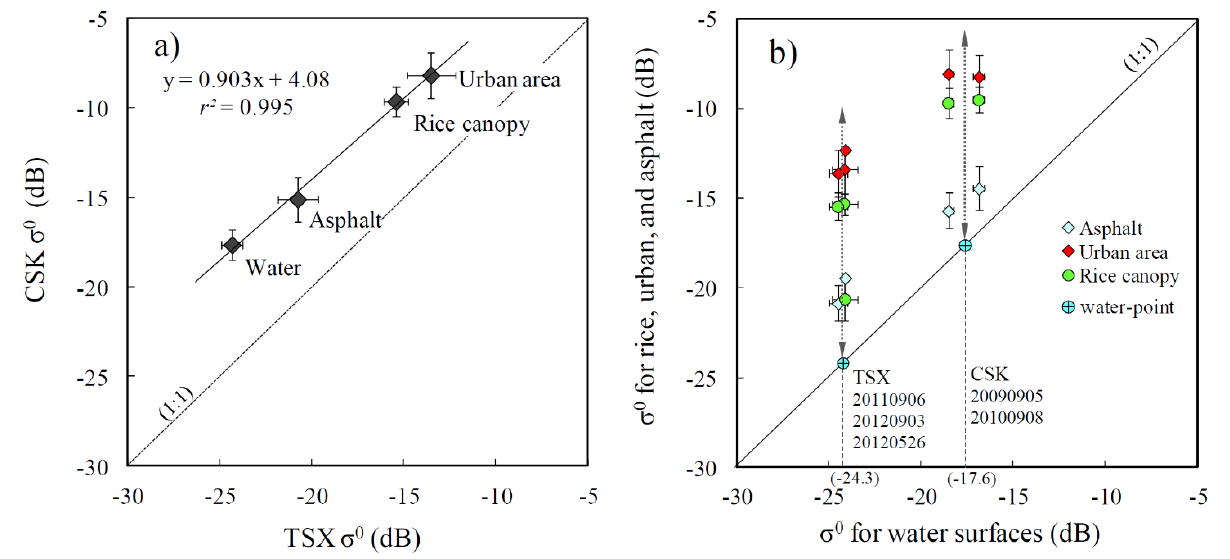
Figure 4. Comparison of σ 0 values in rice canopies, asphalt surfaces, urban areas, and water surfaces obtained by CSK and TSX sensors. ( a ) Comparison of average σ 0 of the four categories in CSK and TSX images during the maturing stage; ( b ) Comparison of σ 0 for rice, asphalt and urban areas against σ 0 for water surfaces. Dates of SAR observations are indicated in yyyymmdd along the “water-line” for CSK and TSX, respectively. The water-point is the intersection point between water-line and 1:1 line.